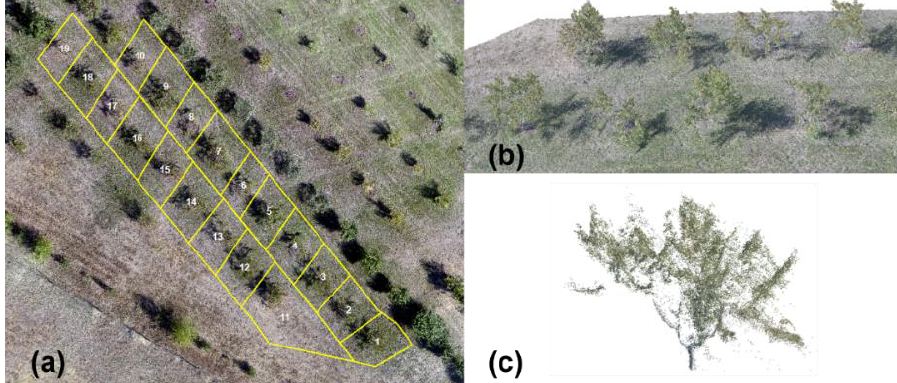
Figure 4. ( a ) Boundary representing the individual peach trees for segmentation, ( b ) 3D point cloud, and ( c ) 3D point cloud of an individual tree after segmentation.